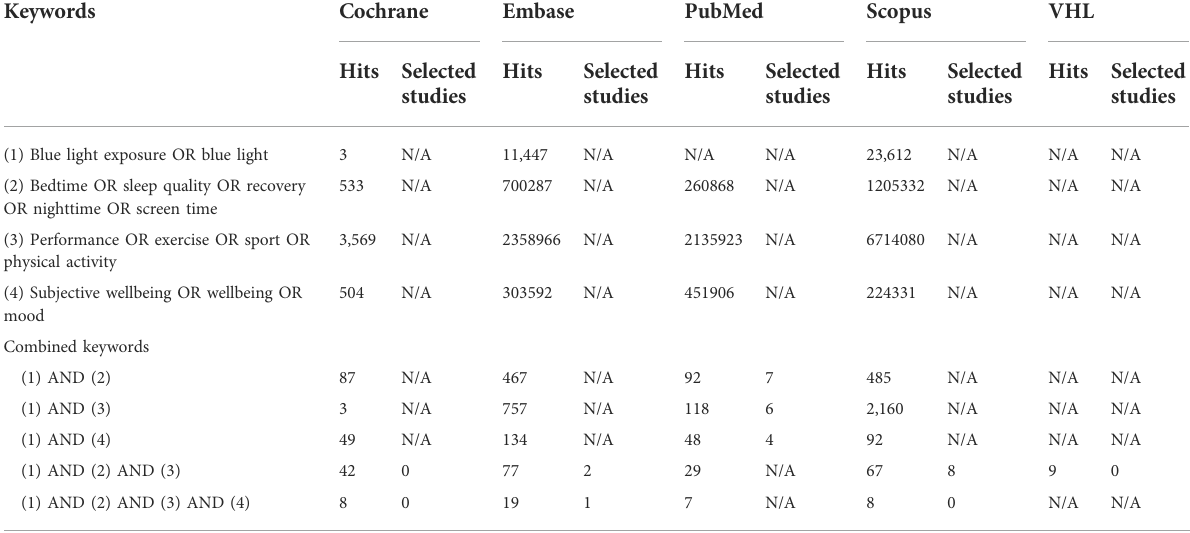
TABLE 1 Overview concerning the search